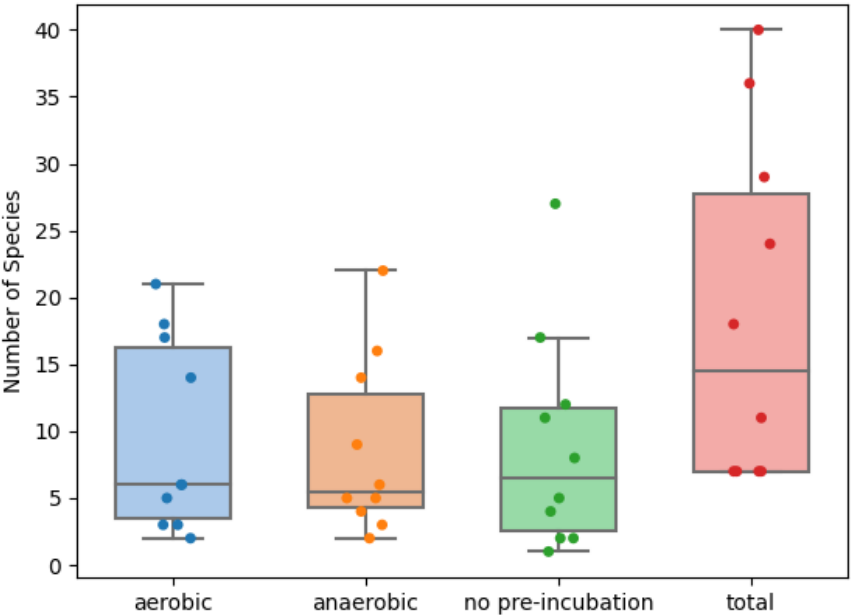
Figure 3. Scattered boxplot for the total number of species found per sample per incubation method (blue: aerobic pre-incubation, orange: anaerobic pre incubation, green: no pre-incubation and red: total).